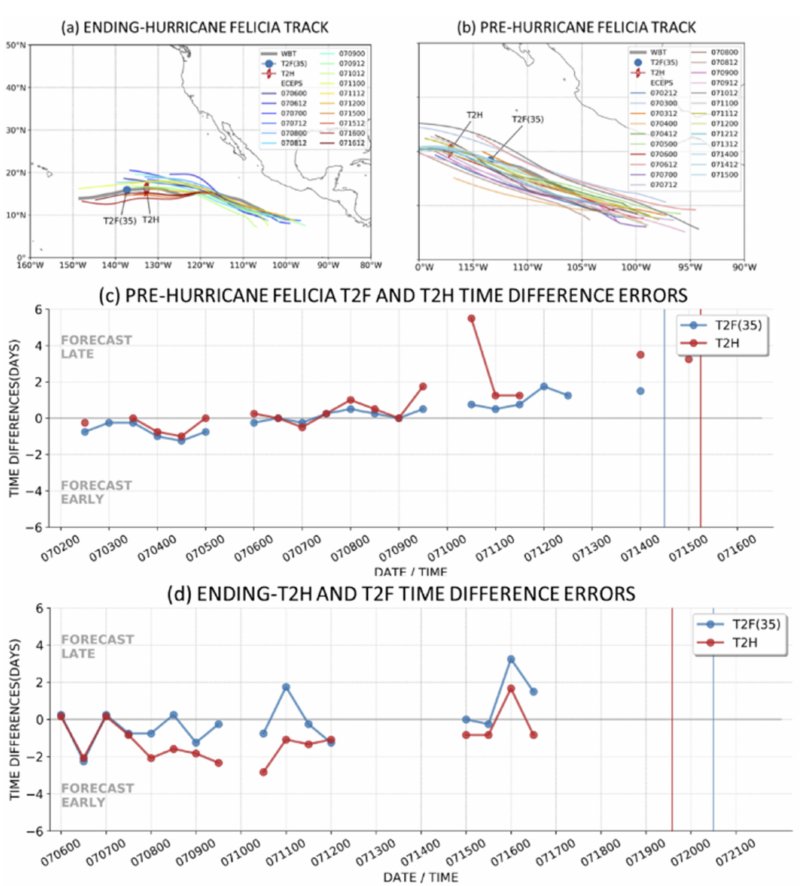
Figure 9. Summary of the ECEPS pre-formation and ending-storm predictions as in Figure 3 except here for the Hurricane Felicia